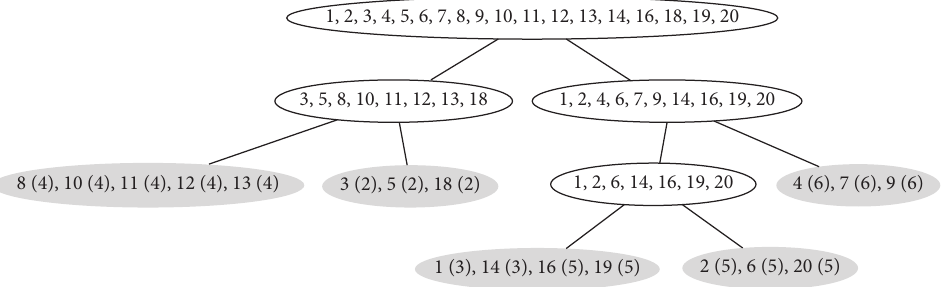
Figure 13: The tree view.